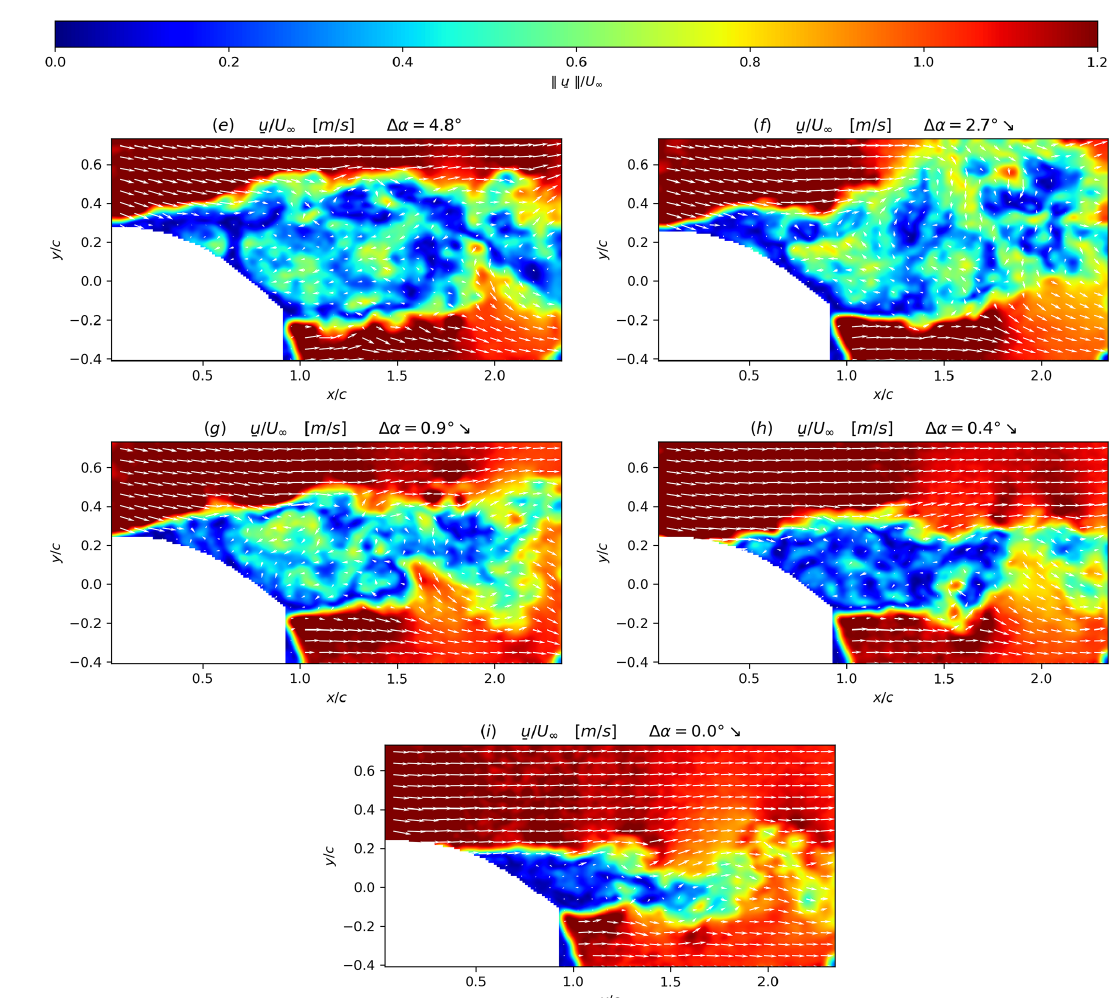
Figure 9. Instantaneous velocity fields superposed with isocontours of the velocity modulus (i.e. (cid:107) u (cid:107) /U ∞ ) at different (cid:49)α values corre- sponding to points of the blade oscillation given in Fig. 7 during the downstroke phase (noted (cid:38) ): (e) corresponds to a point at the maximum amplitude of the blade oscillation cycle, (f) is an intermediate point, (g) is a point just prior to the flow reattachment, (h) is a point just after the flow reattachment and (i) is a point at the lowest (cid:49)α of the downstroke